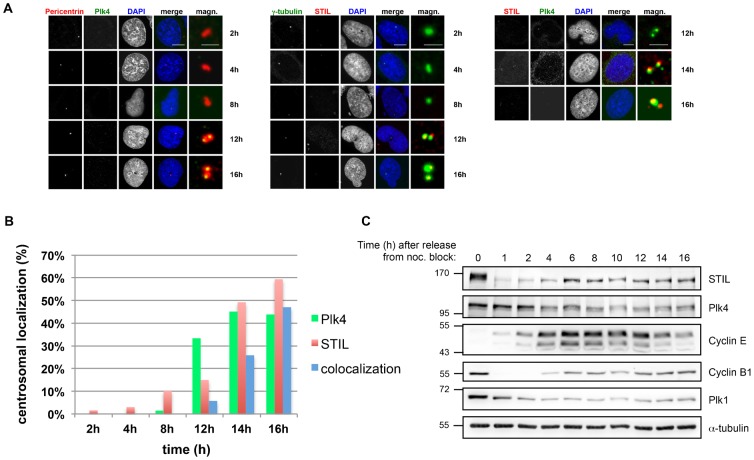
Colocalization of STIL and Plk4 at the onset of S phase.(A–C) U2OS cells were arrested in S-phase with 1.6 µg/ml aphidicolin for 17 h, released for 5 h and then rearrested in prometaphase by addition of 100 ng/ml nocodazole for additional 16 h. The cells were released and harvested at the indicated time points. (A) For indirect immunofluorescence analysis, cells were fixed and stained with antibodies against Plk4, pericentrin, STIL and γ-tubulin. Scale bars: 10 µm (merge), 2 µm (magnifications). (B) Centrosomal localization of Plk4 and STIL was quantified for the indicated time points by counting colocalization with the centrosomal marker proteins γ-tubulin and pericentrin. For each time point on average 60 cells were counted. (C) Synchronization of the cells was confirmed by western blot analysis using antibodies against Plk1, Plk4, Cyclin E, Cyclin B1, STIL, and α-tubulin.